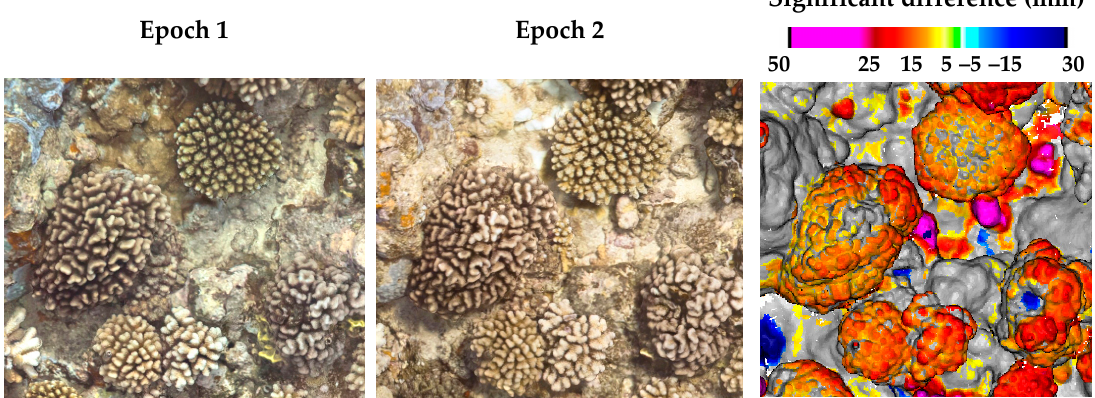
Figure 16. Details of the orthophotos for the two epochs (2018 and 2019) over the test site together with a map of the significant differences (right).